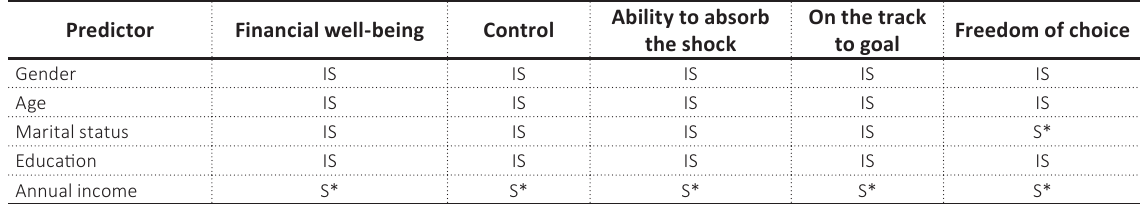
Source: Analysis of survey